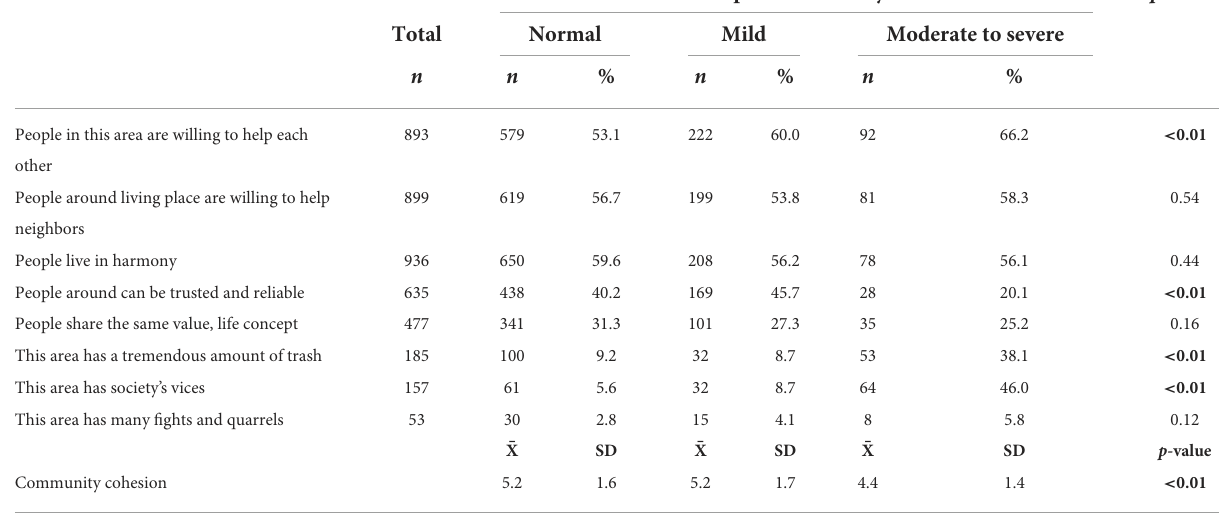
TABLE 2 Neighborhood characteristics of respondents. Characteristics